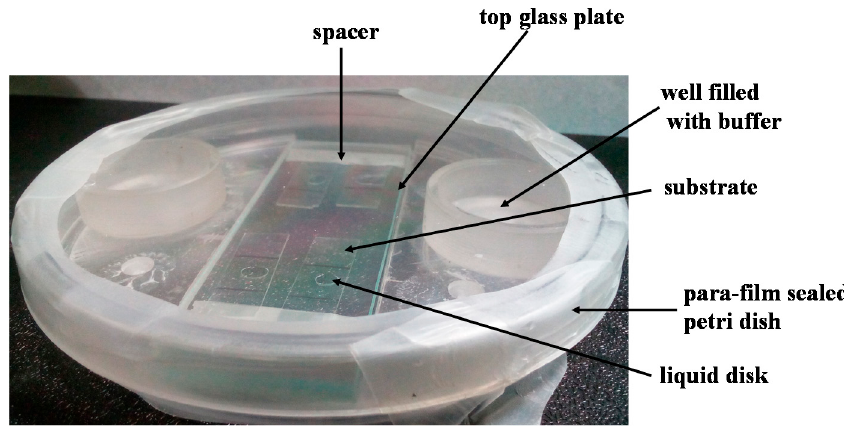
Figure 1. Schematic of crystallization set up.